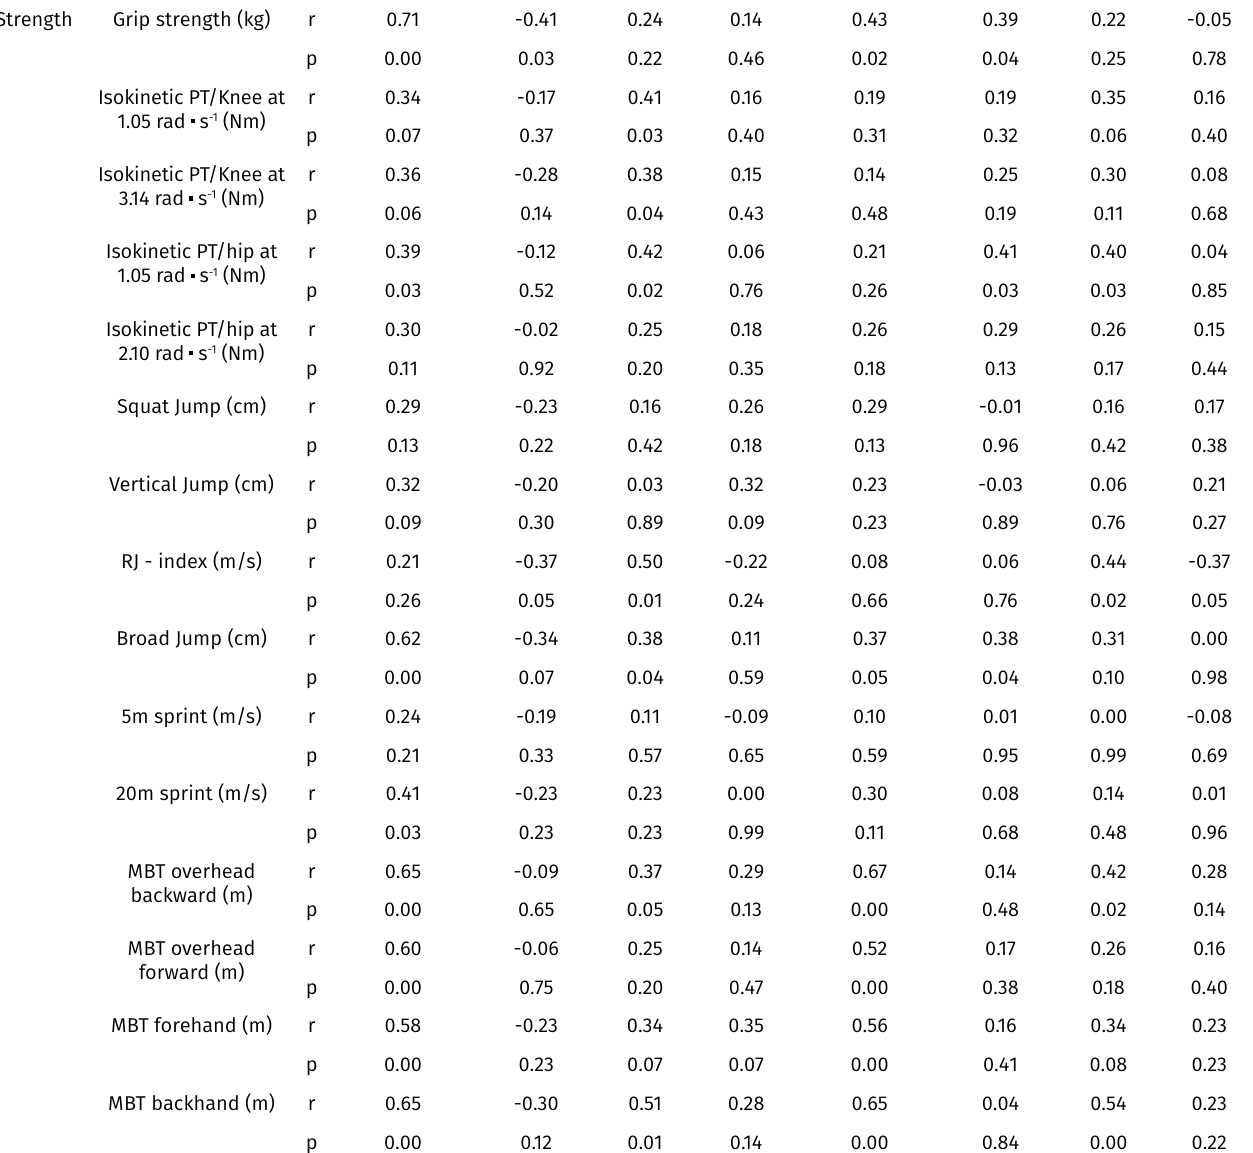
Table 2-1. The partial correlation coefficient of physique and physical strength versus service performance in male players (Continuation). Strength